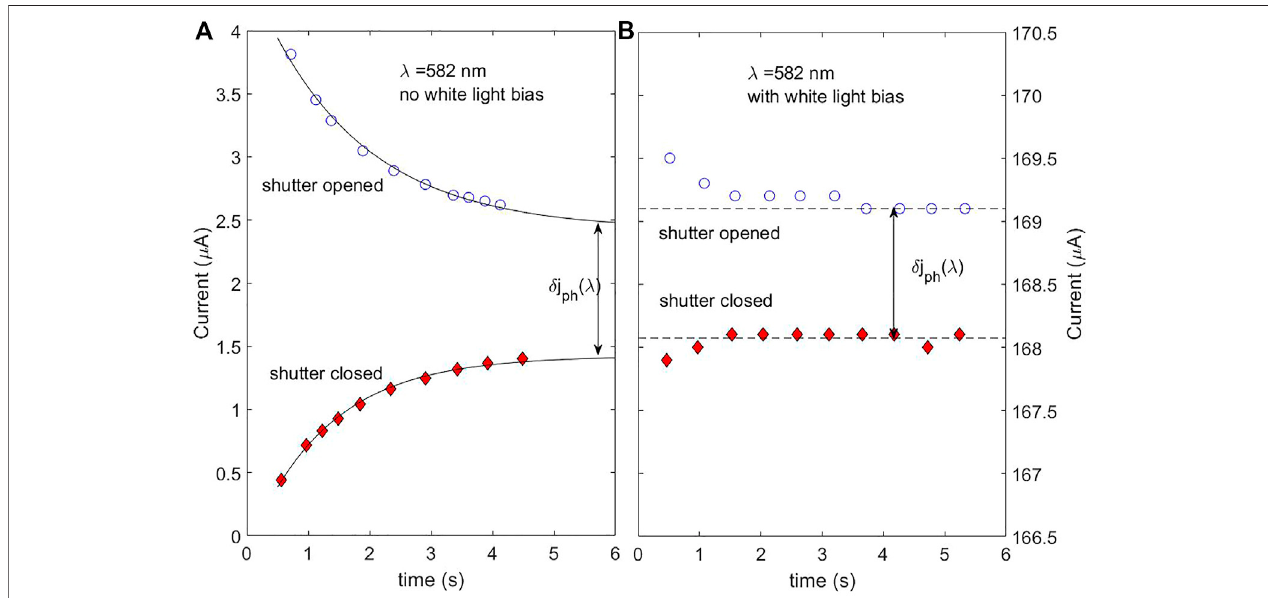
FIGURE 5 | Effect of light bias on small-signal photocurrent response to a step in the light intensity. The sample was a 1 μ m thick, Ti-doped hematite layer over an FTO conductive layer, measured with monochromatic light incident on the back of the sample. The applied potential was set to 1.6 V RHE, well above the photocurrent onset (at ∼ 1.2 V RHE, not shown), but near the onset of dark current (A) Without light bias (B) with ∼ 1 sun white light bias, incident on the front of the sample. Note that the photocurrent scale spans the same 4 μ A as in (A) , but offset by the current contribution from the LED bias ( ∼ 166.5 μ A).